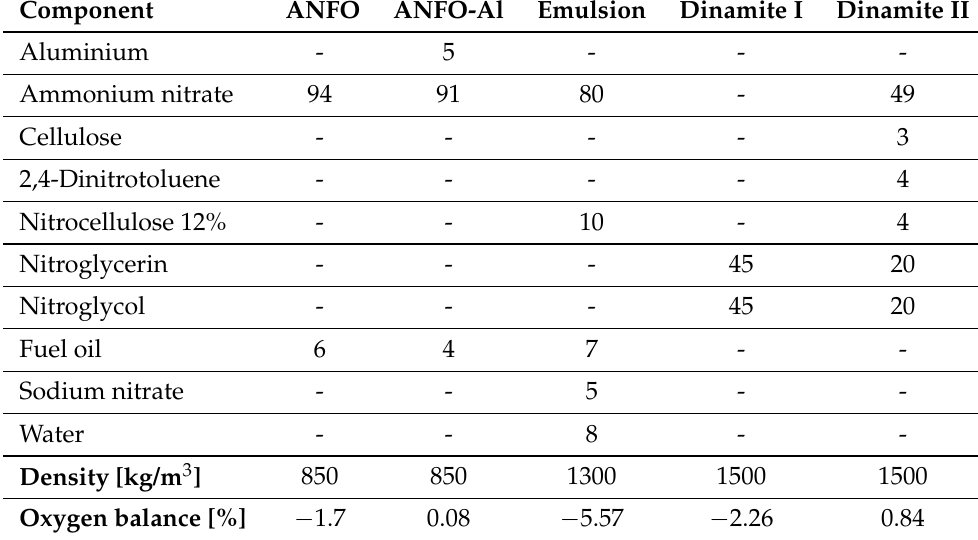
Table 2. Composition [mass %], density, and oxygen balance of different explosive mixtures tested.